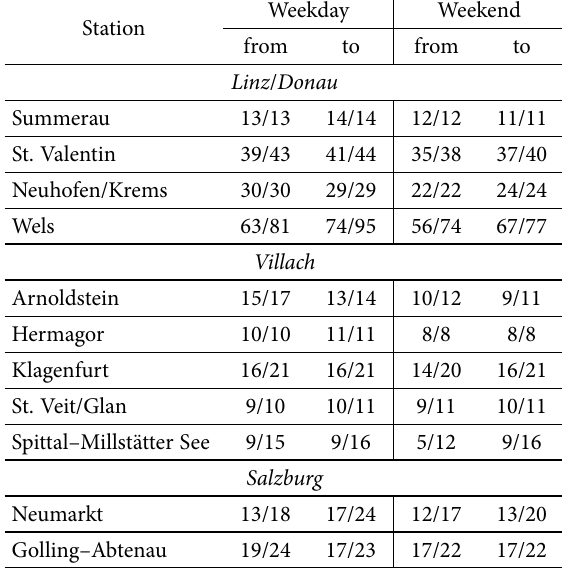
Table 5. Accessibility of trains in chosen regions of Austria